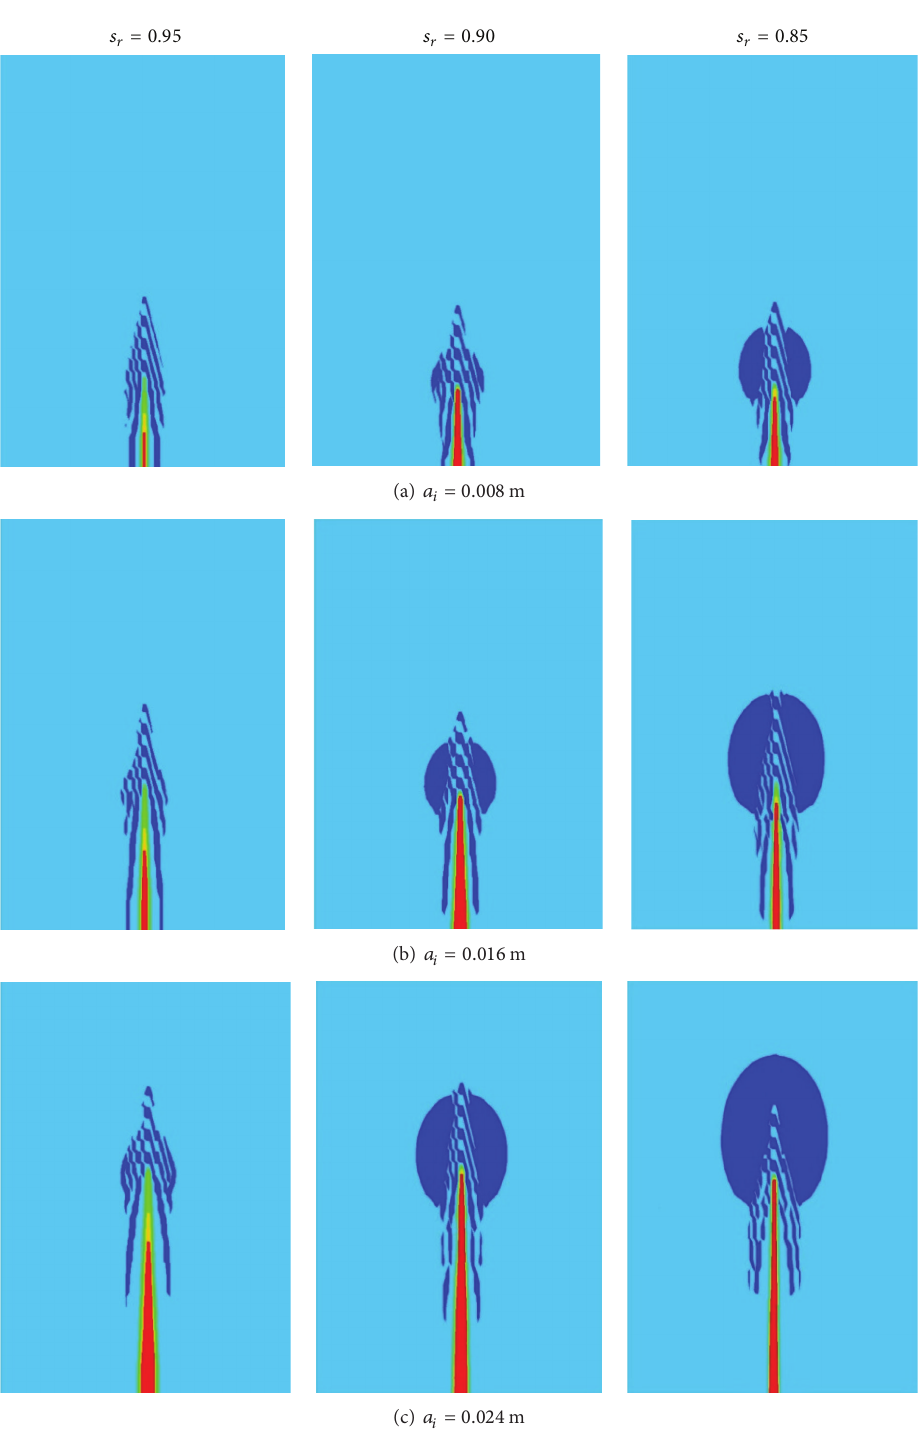
(NPZ) may explain the dependence between fracture tough- ness and saturation and length of starter slot. Figure 4 shows the NPZ before facture tip. Only half of the simulated domain is displayed because of symmetry. When the saturation is higher (0.95), the area of NPZ and the length of the starter